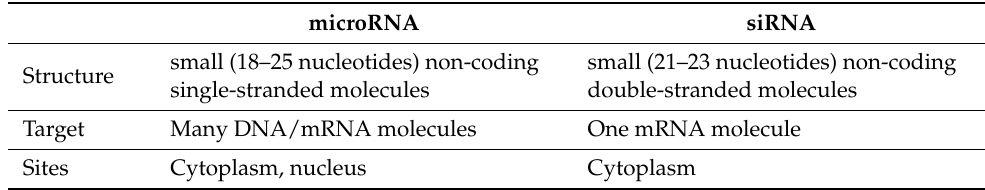
Table 1. The differences between microRNA and siRNA. microRNA siRNA small (18–25 nucleotides) non-coding small (21–23 nucleotides) non-coding Structure single-stranded molecules double-stranded molecules Target Many DNA/mRNA molecules One mRNA molecule Sites Cytoplasm, nucleus